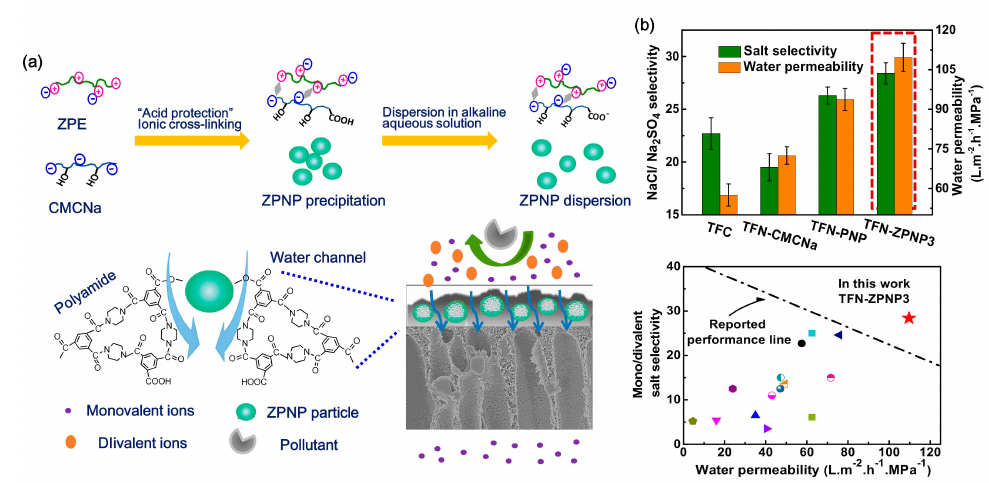
Figure 18. ( a ) Fabrication of ZPNPs and their thin-film nanocomposite (TFN) nanofiltration membranes; ( b ) Separation performances of TFC, TFC-CMCNa, TFN-PNP, and TFN-ZPNP3 membranes tested with pure water and 1 g L − 1 aqueous Na 2 SO 4 and NaCl solutions (pH = 7.0) at 25 ◦ C and 0.6 MPa; comparison of the TFN-ZPNP3 membrane with various polyamide membranes reported in previous studies. Reproduced with permission from Reference